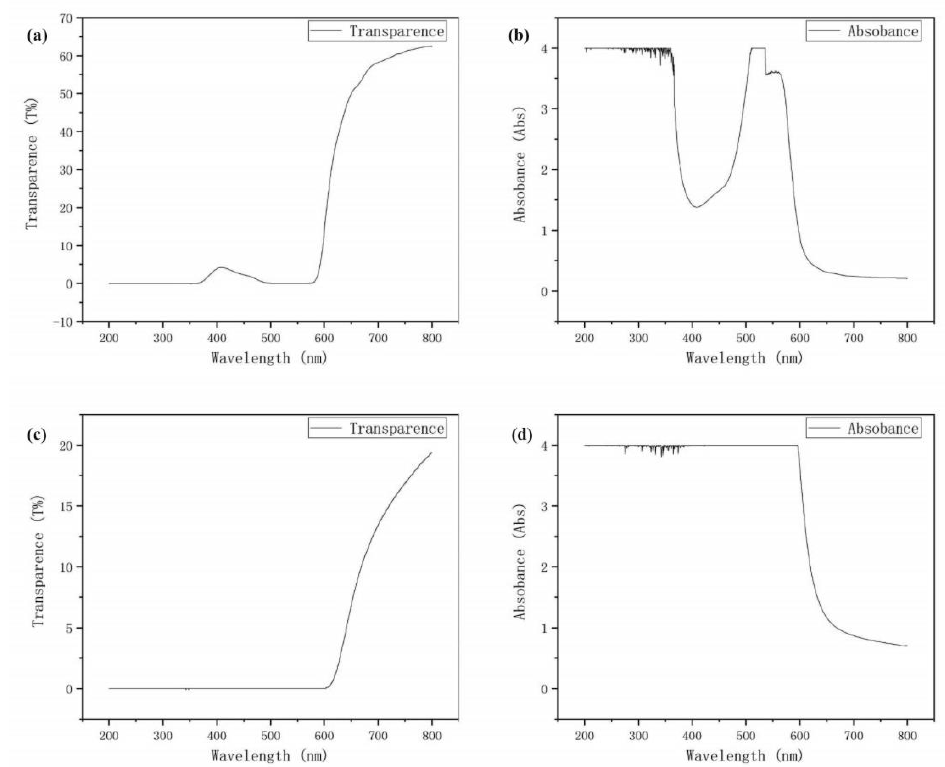
Figure 5. Ultraviolet-visible light transmittance ( a ) and absorbance ( b ) of the leachate with ethanol of dried hibiscus flower and the visible light transmittance ( c ) and absorbance ( d ) of the leachate with water. It is undeniable that after adding any kind of thickener, the performance of the ob- tained dye-sensitized solar cell decreases. As per Figure 6, the JV curves of different thick- eners in dye layer indicate that the performance of Simulgel with 7 wt.% is the best (the thickener of the electrolyte is 5 wt.% xanthan gum). V oc , Jsc, and FF for Figure 6 are in Table 1.